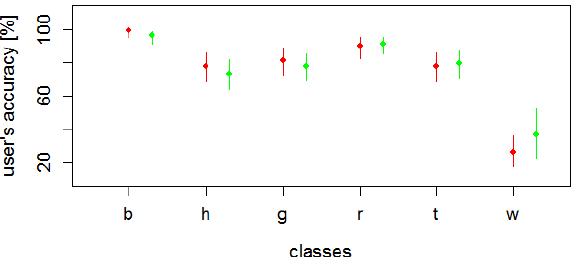
Figure 8. User’s accuracy at DT classification (red=independent checkpoints , green=cross validation, n c